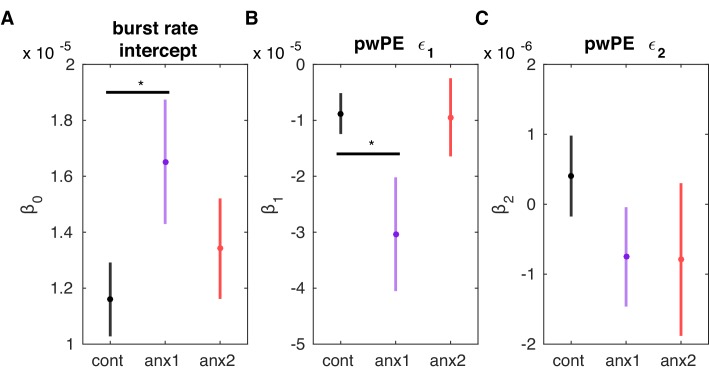
The rate of long beta bursts following feedback is modulated by the magnitude of precision-weighted prediction errors relating to reward.(A–C) Same as Figure 10A–C but for the grand-averaged rate of post-feedback long beta bursts. The β0 and β1 regression coefficients were significantly different than 0 for each group (PF⁢D⁢R<0.05). Further to this result, β0 was positive and larger in anx1 than in control participants (PF⁢D⁢R<0.05). By contrast, the regression coefficient β1 was negative and significantly smaller in the anx1 group than in the control group (PF⁢D⁢R<0.05). This outcome resembles the results in Figure 10A–C, suggesting that smaller pwPE on reward contributed to a larger rate of long beta bursts. The second regressor coefficient β2 did not differ significantly from zero and changes in ϵ2 did not contribute to better explaining the beta activity (see main text). Anx2 participants did not have significantly different regressor coefficients than the control group. In summary, the multiple regression results linked a higher post-feedback rate of long-lived oscillation bursts (as observed in anx1) with reduced updates about reward.